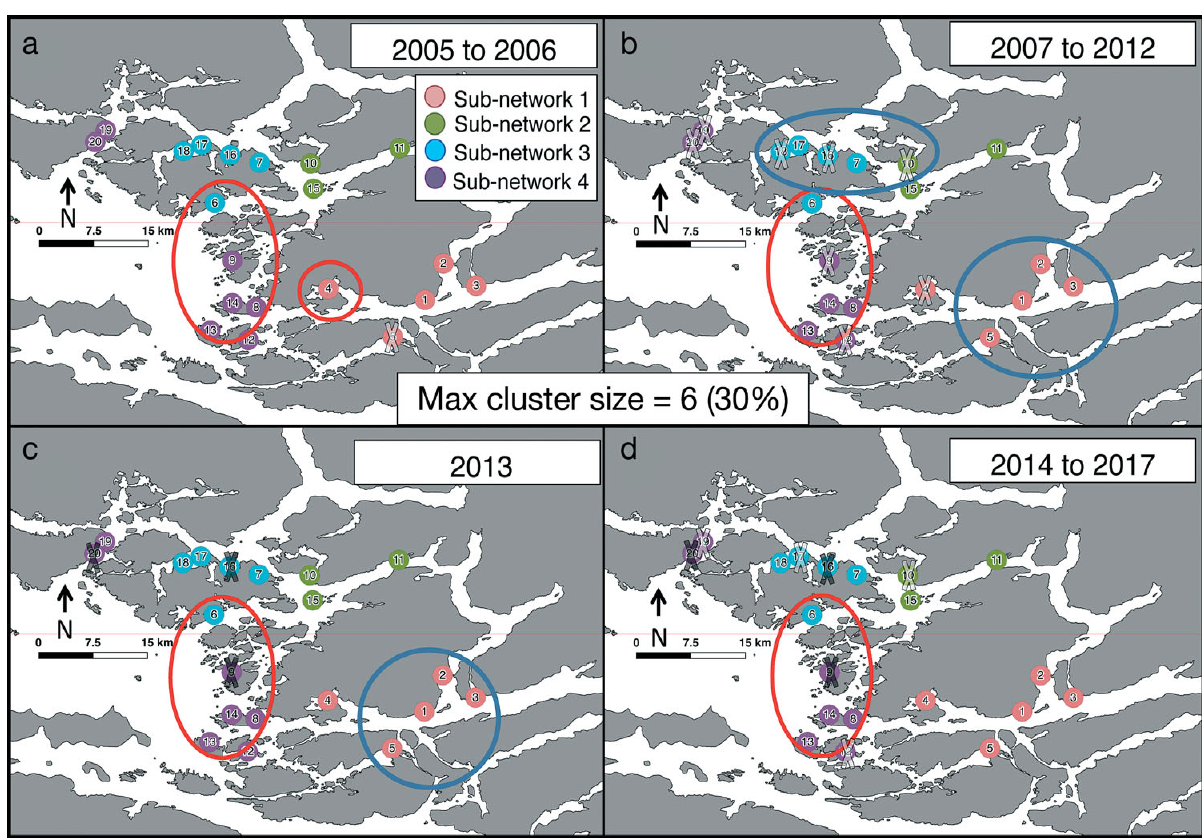
Fig. 5. SaTScan results from a spatial window that may include up to 30% of farms, with significant (p < 0.05) high-risk (red) and low-risk (blue) clusters of farms for sea lice counts (log-transformed) over the study period. The analyses were carried out with monthly time steps and summarised by years (inclusive) to capture overalls through time: (a) 2005−2006; (b) 2007−2012; (c) 2013; (d) 2014−2017. Black, semi-translucent ‘X’s placed on farms indicate the farm was not active for the entire duration of time period represented in the panel; light grey ‘X’s indicate the farm was not active for some duration of the time period represented in the panel